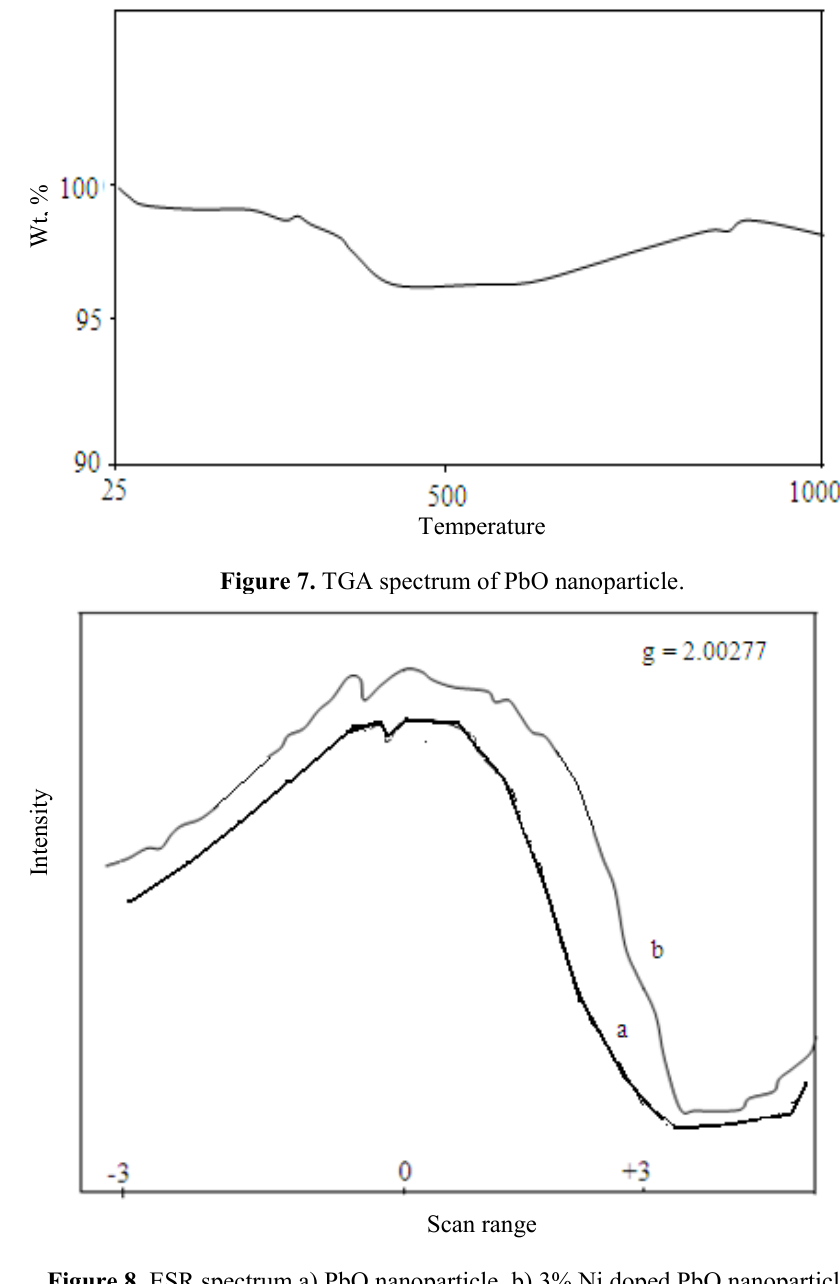
Figure 8. ESR spectrum a) PbO nanoparticle, b) 3% Ni doped PbO